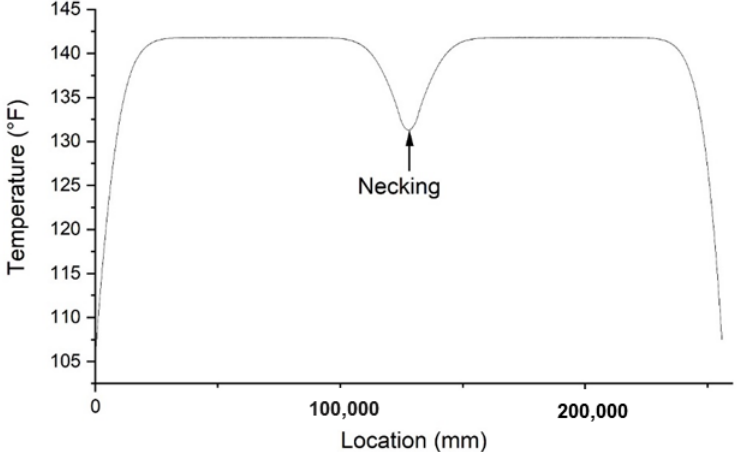
Figure 5. Temperature distribution on the optical fiber with necking defect. The location on the x-axis is given as the length of the virtual optical fiber tied spirally around the virtual reinforcement cage within the shaft.